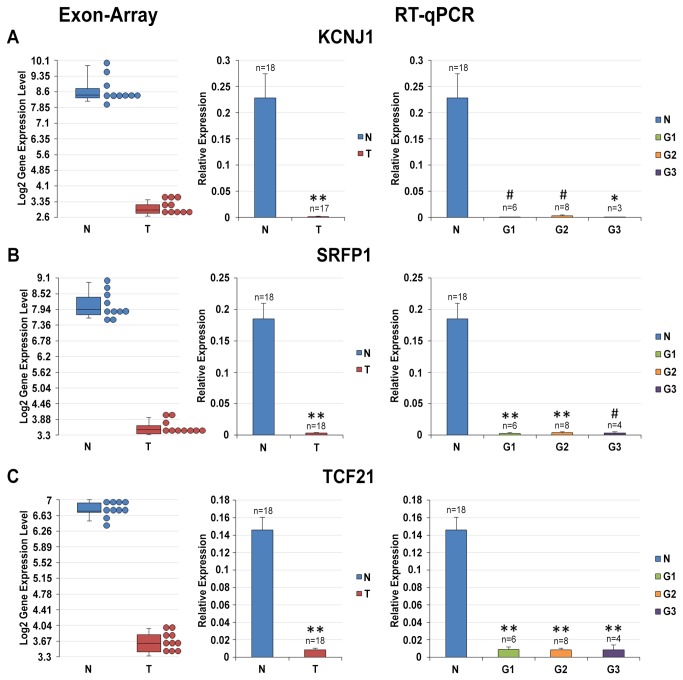
Gene Expression analysis of KCNJ1, SFRP1 and TCF21 genes.Expression levels of KCNJ1 (A), SFRP1 (B) and TCF21 (C) genes were calculated relative to the mean expression levels of ACTB and RPL13 genes. From left to right: box plot of log2 gene expression intensities resulting from microarray analysis (each dot stands for a sample); histogram of the expression levels (mean ± SE) of target genes in NT and ccRCC samples; histogram of the expression levels (mean ± SE) of target genes in NT and G1, G2 and G3 ccRCC samples. * = p-value < 0.05; # = p-value < 0.01; ** = p-value < 0.001.